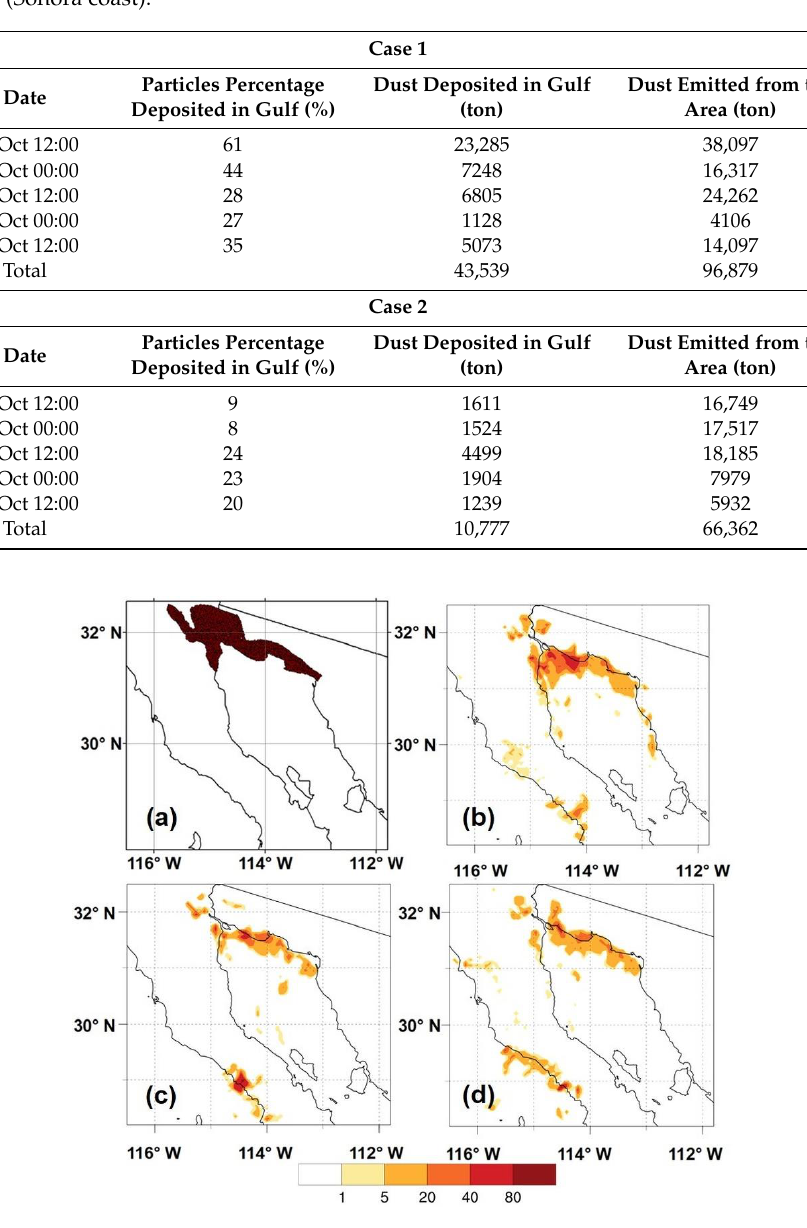
Figure 10. (a) Initial positions of particles in Altar Desert area and distribution maps of number of deposited particles per grid point of experiments on (b) October 22 at 00:00 UTC, (c) October 22 at 12:00 UTC and (d) October 23 at 00:00. Grid of 0.05 degrees’ resolution.